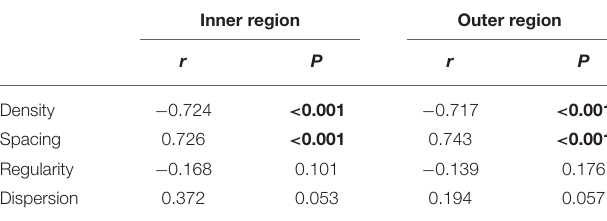
TABLE 2 | Correlations between AL and cone spatial distribution